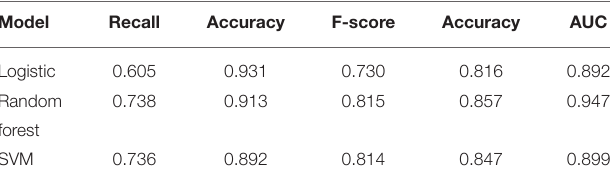
TABLE 2 | The performance comparison of data processed by health diagnosis and intelligence development of children with three classification models applied to health information statistics.